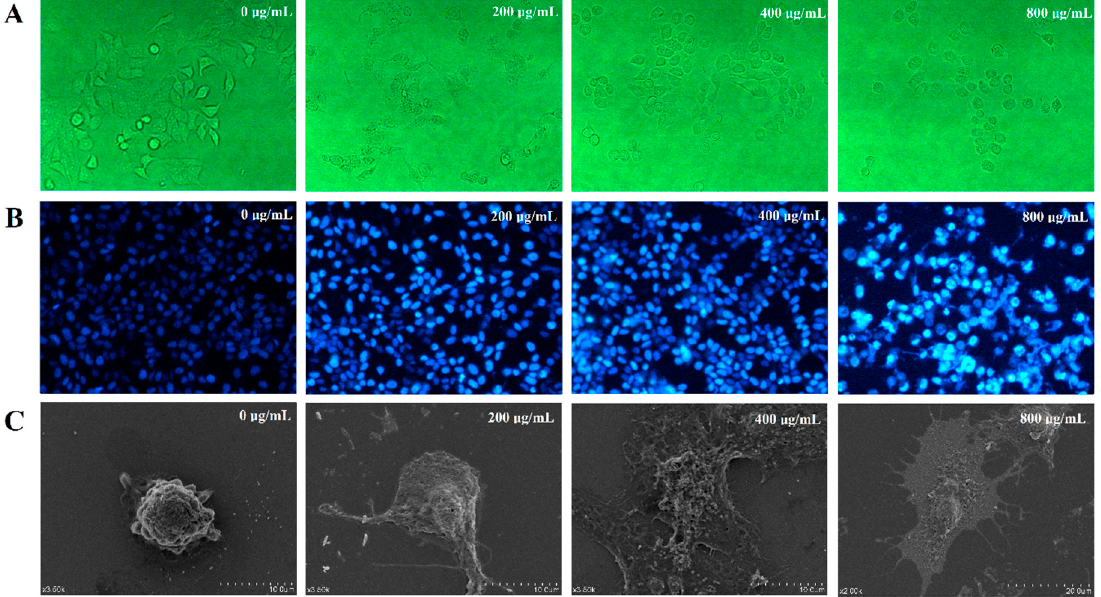
Figure 5. ( A ) Cell morphology in HepG2 treated and untreated cells was observed by inverted mi- croscope. ( B ) Apoptosis was detected by Honest 33258 staining. ( C ) Cell morphology was observed by